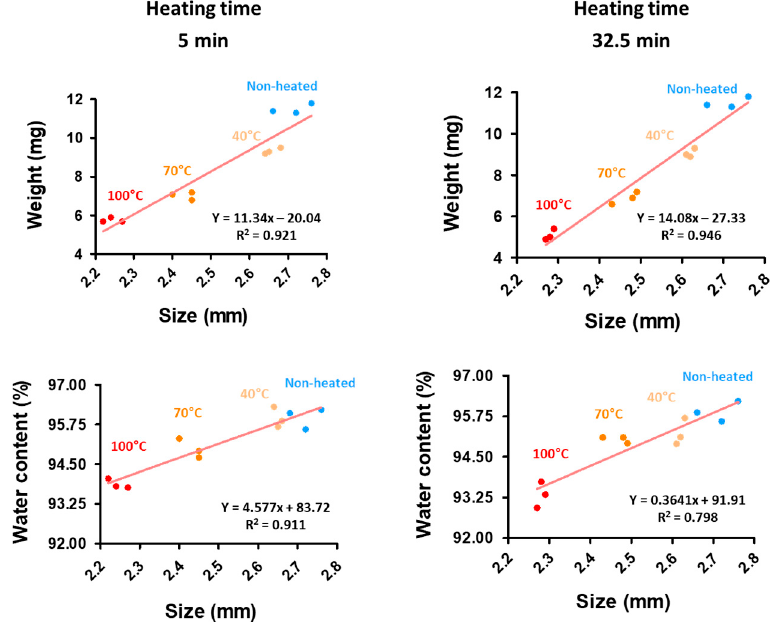
Figure 4. Correlation between weight (mg) and size (mm), water content (%), and size (mm) at 5 min; and weight (mg) and size (mm), water content (%), and size (mm) at 32.5 min.